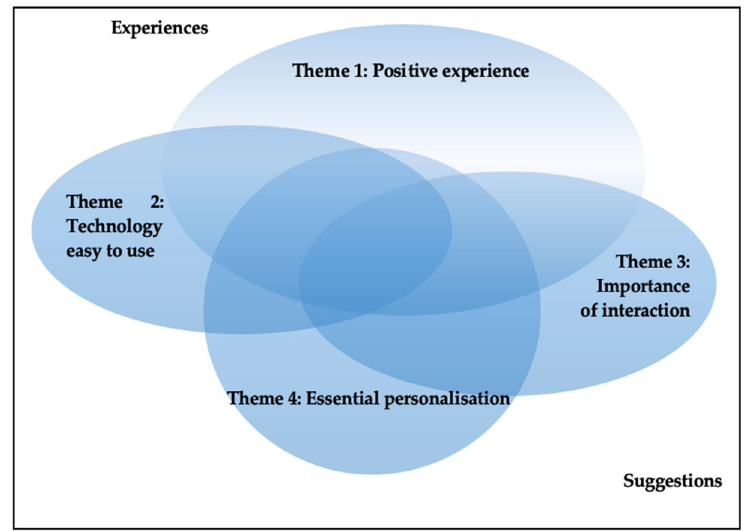
Figure 2. Illustration of the findings represented by the four